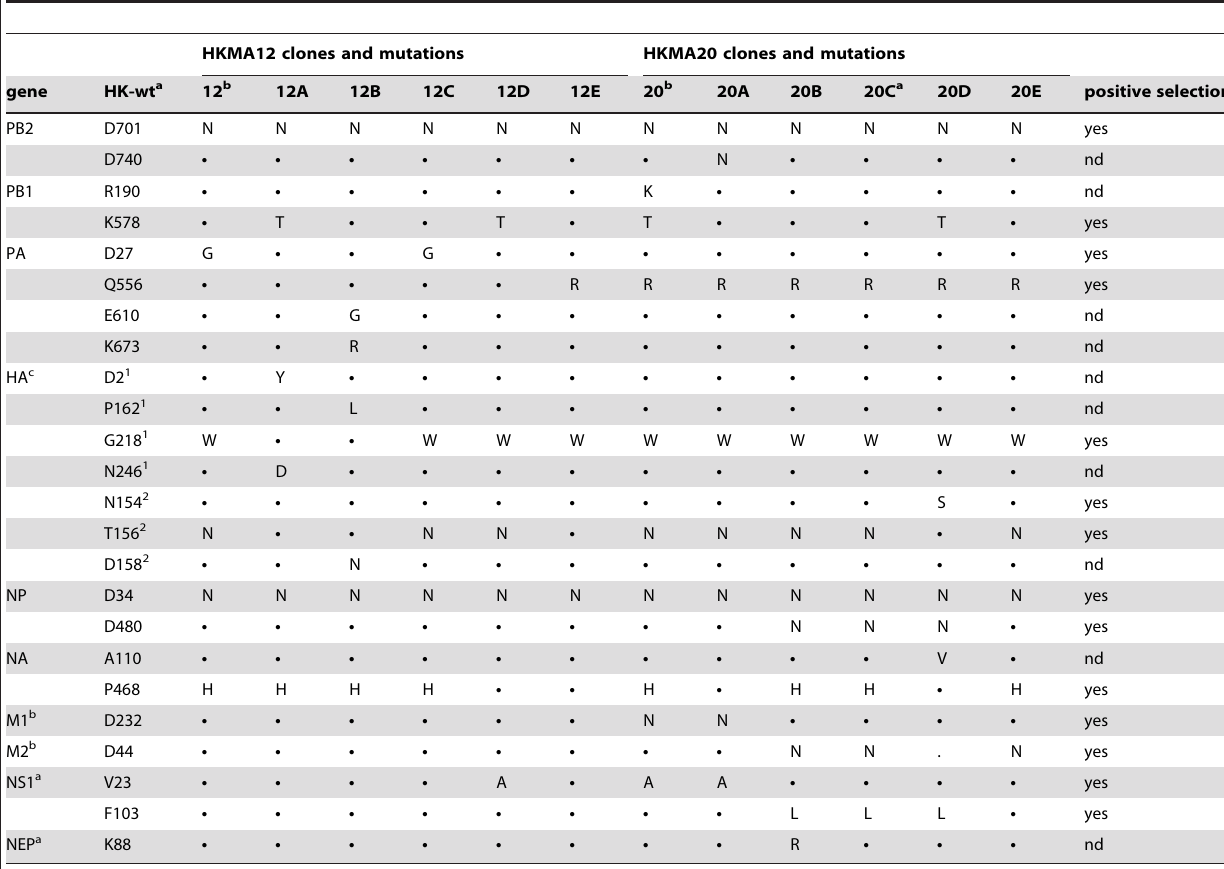
Table 2. Mutations in genomes of mouse-adapted variants obtained after 12 and 20 mouse-lung passages relative to HK-wt.